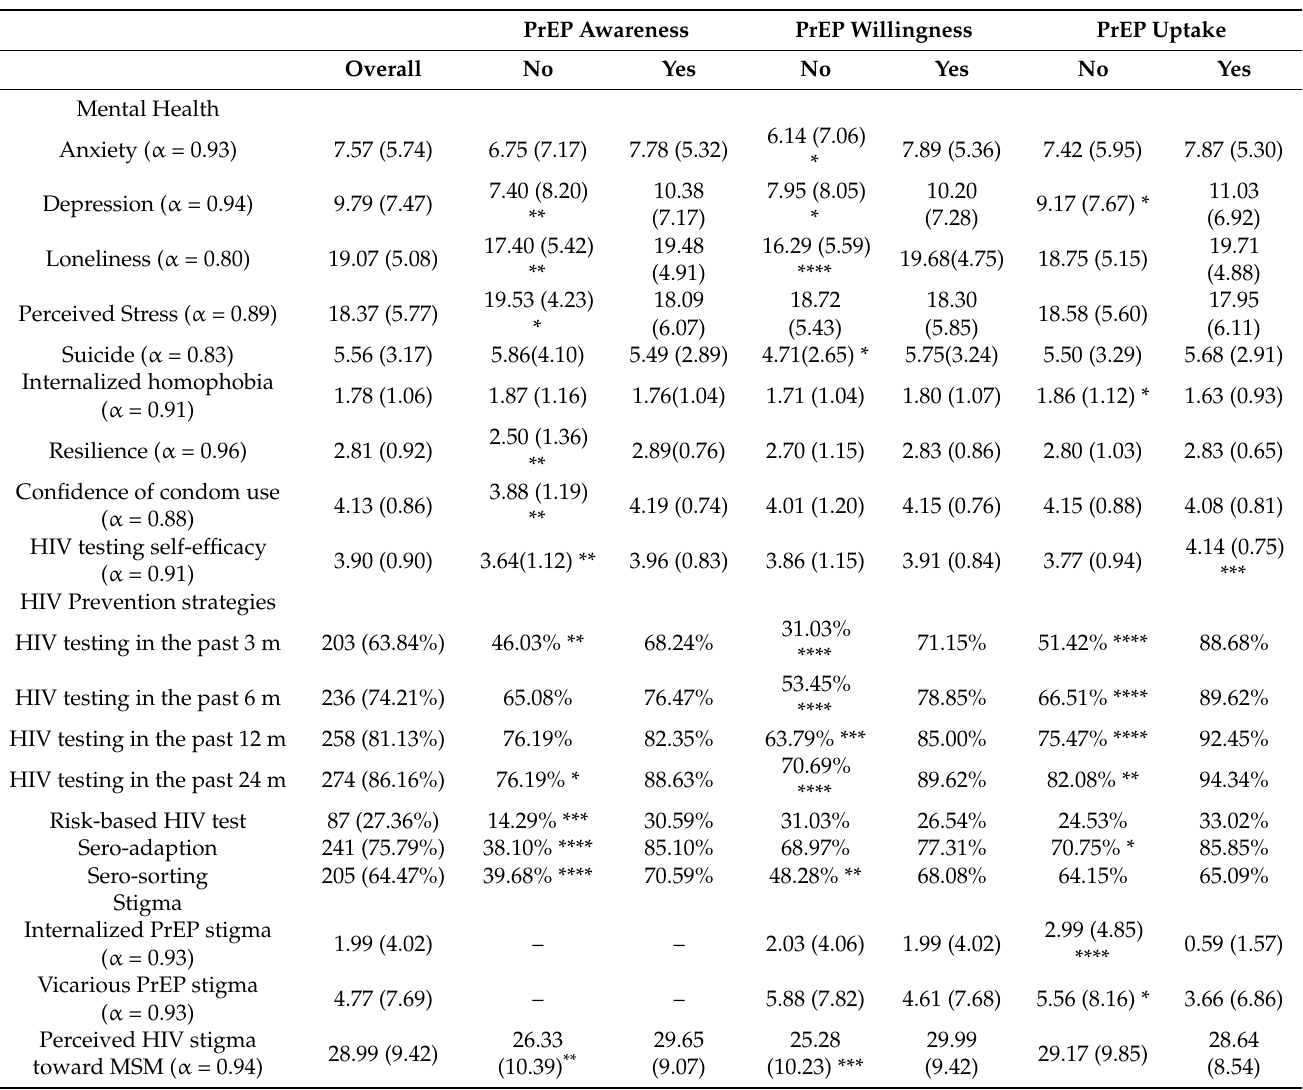
Table 2. Mental health, HIV prevention strategy, and HIV-related stigma by PrEP cascade status ( n = 318). PrEP